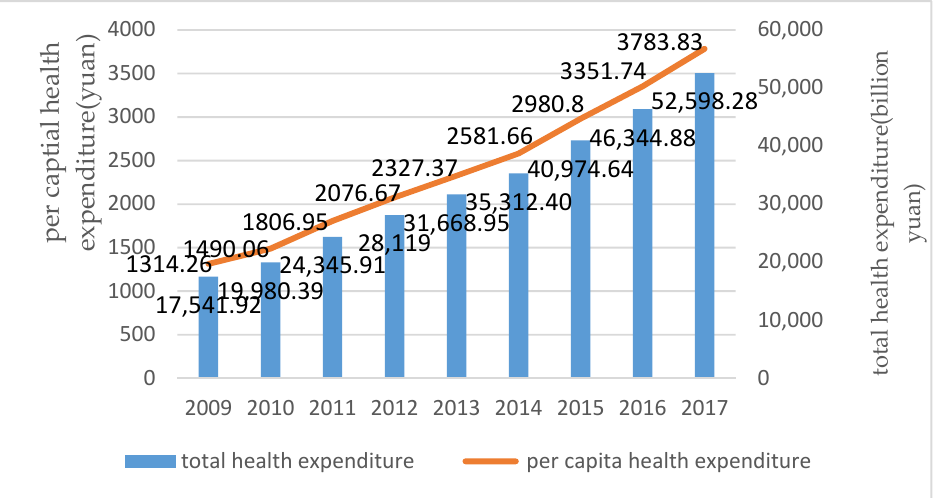
Figure A1. Changes of total health expenditure and per capital health expenditure.